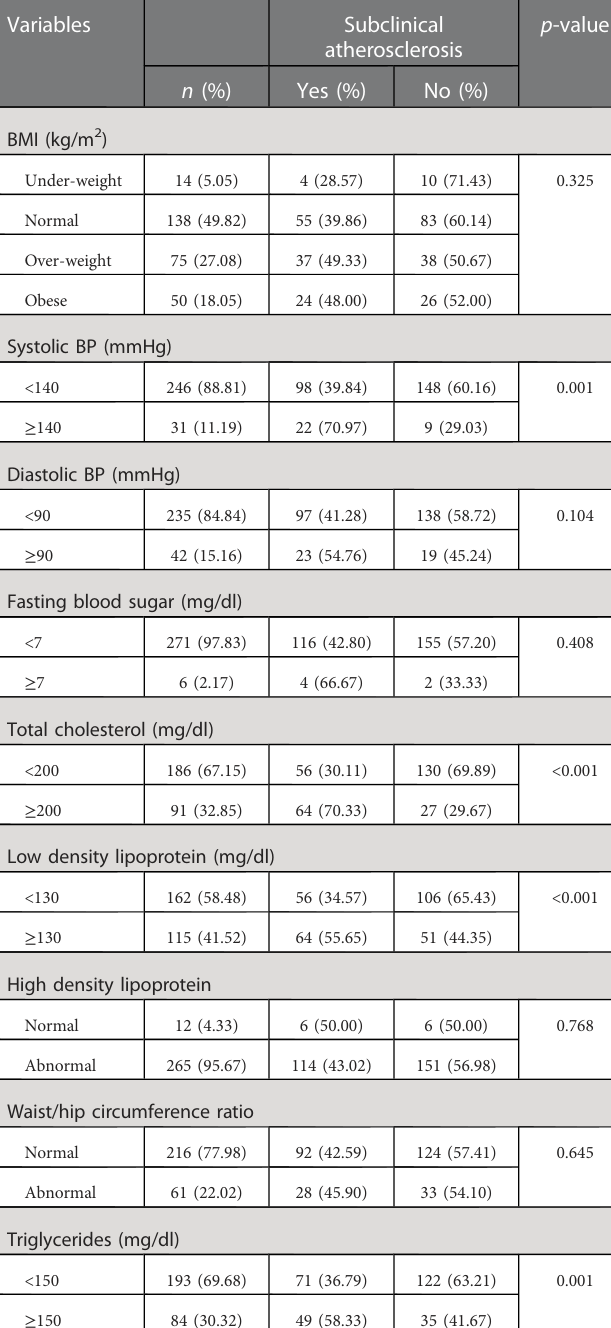
TABLE 2 Clinical parameters and associations with subclinical atherosclerosis.